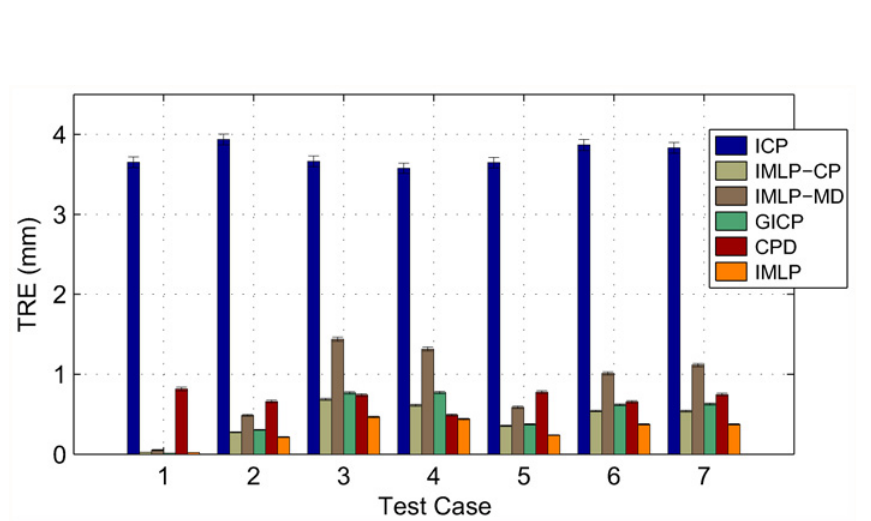
Fig 8. Registration errors for registering a sub-shape. (Experiment 6). Source shapes were randomly generated from a sub-region of a mesh model of a human proximal femur (Fig. 1B), misaligned by [10, 20] mm / degrees, and registered back to a point-cloud representation of the mesh. The test cases represent the different noise models used to generate noise on the source shape (Table 11). For each test case, 300 randomized trials were conducted, with successful registrations being used to compute an average target registration error (TRE). The error bars provide approximate standard deviations of the reported average TRE values. The proposed IMLP algorithm was evaluated relative to standard ICP [1], GICP [11], and CPD [20], as well as relative to near-comparisons of GTLS-ICP [10] and A-ICP [12] using the two variants IMLP-CP and IMLP-MD, which modify IMLP ’ s most-likely match criteria to that of closest-point and Mahalanobis-distance matching,